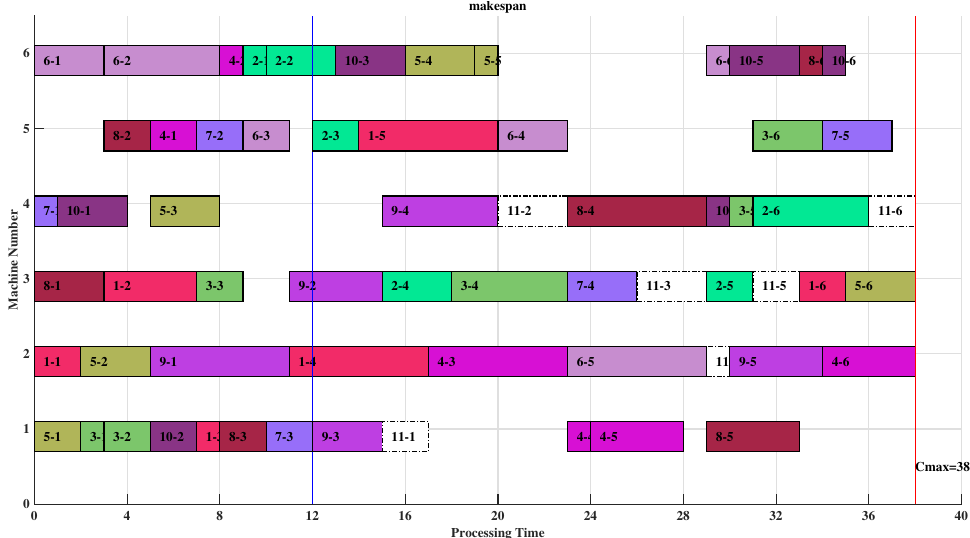
Figure 20. The rescheduling scheme obtained by the DSLABC